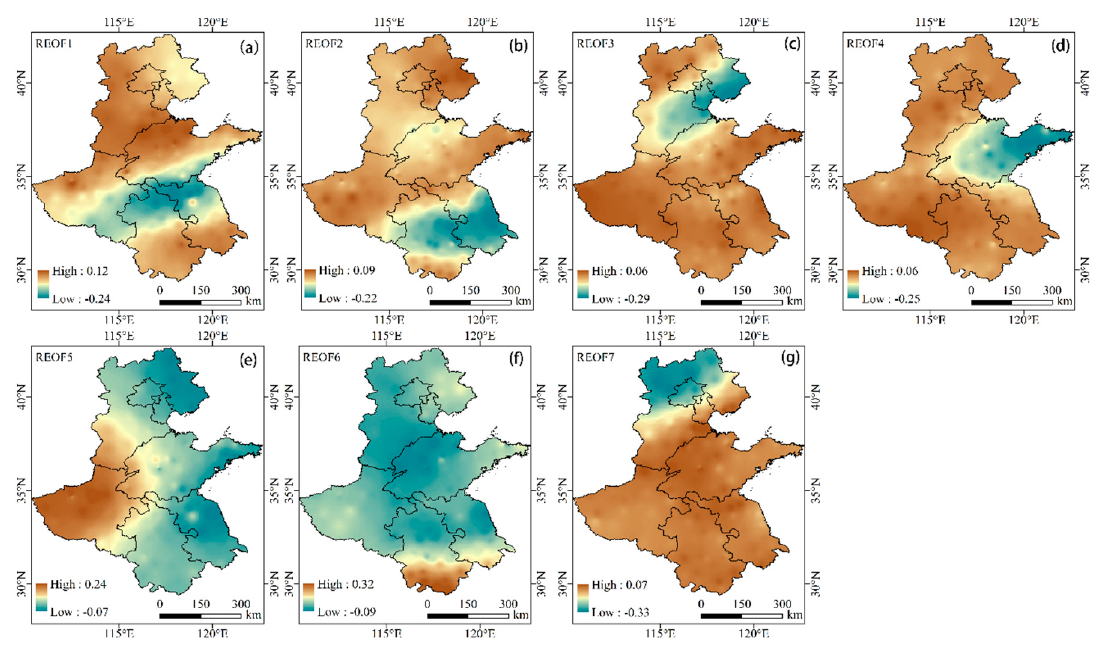
Figure 2. Spatial models recognized in the North China Plain for drought variability; ( a – g ) represent the spatial models obtained by REOF as the rotation factor load vector. Each model represents the spatial correlation distribution structure.